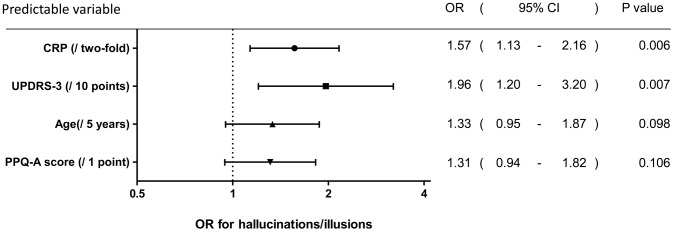
Relative risk of hallucinations/illusions estimated as odds ratios (ORs) using a multi-variable regression model.Predictable variables were selected using a backward likelihood test, and plasma level of CRP, age, and MMSE score incorporated into the model.